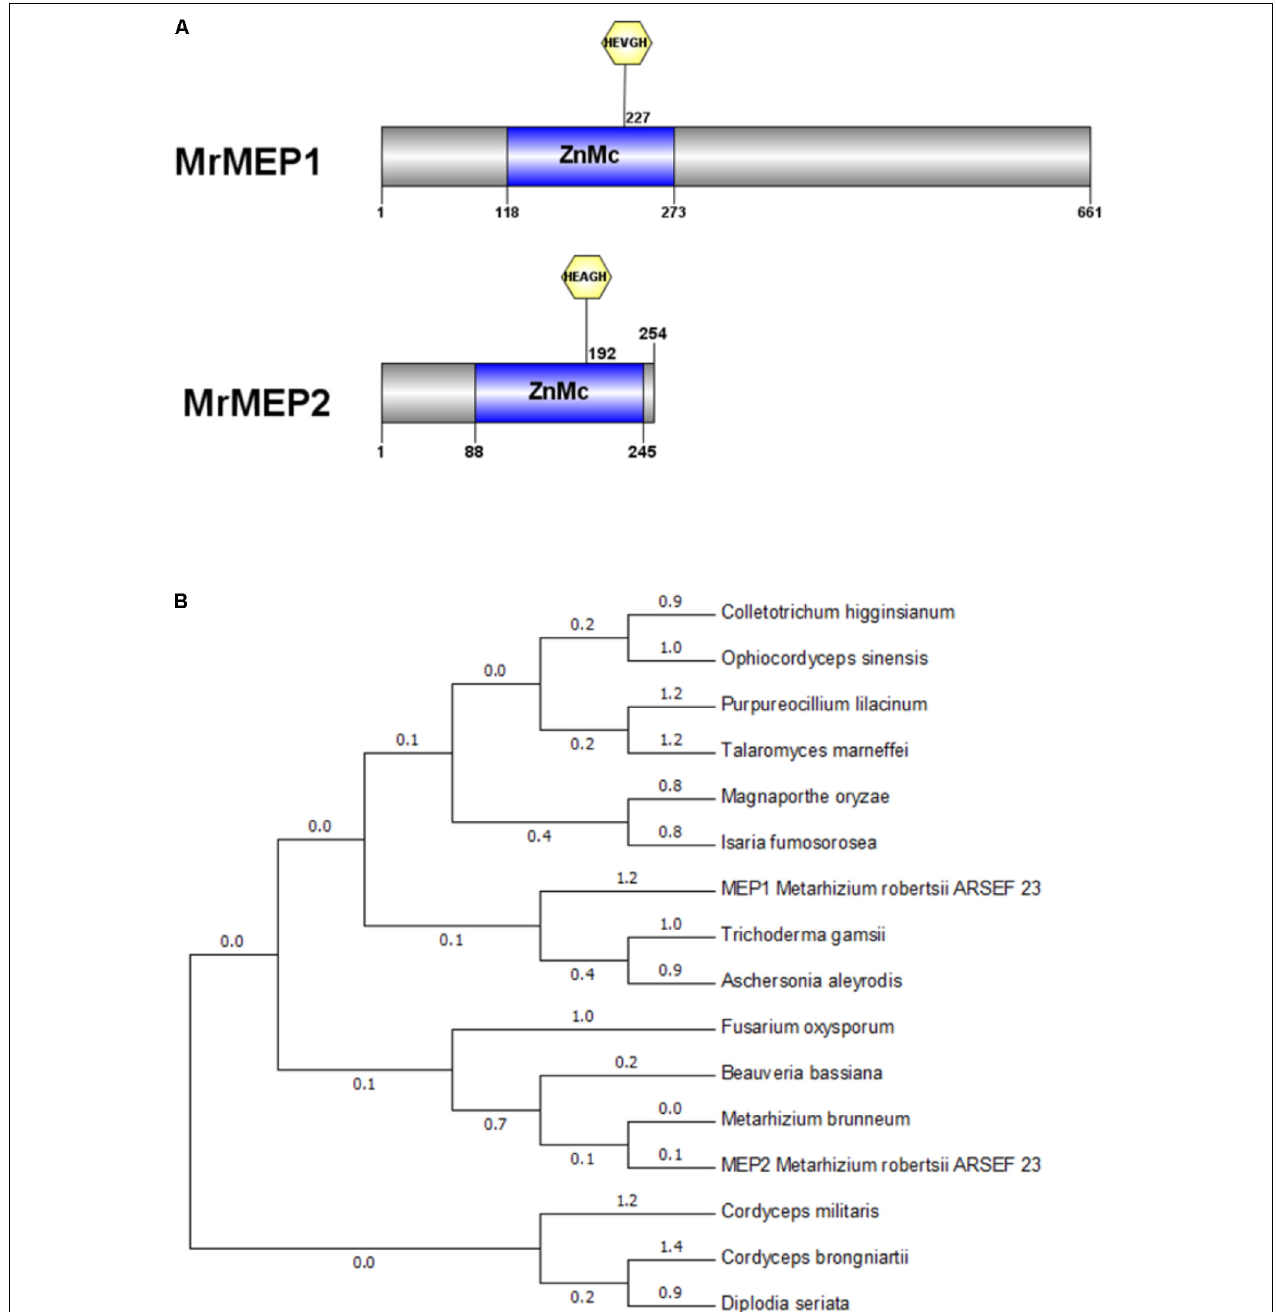
FIGURE 1 | Bioinformatic analysis of MrMEP1 and MrMEP2 proteins. (A) The structural domain sites in MrMEP1 and MrMEP2 proteins. (B) Phylogenetic analysis of the fungal MEP proteins. Phylogenetic trees constructed with fungal MEP proteins. The protein accession numbers as follows, EWZ30531.1 hypothetical protein FOZG_16010 [ Fusarium oxysporum Fo47]; PNP41669.1 hypothetical protein TGAMA5MH_06456 [ Trichoderma gamsii ]; XP_018155334.1 metalloprotease [ Colletotrichum higginsianum IMI 349063]; XP_018179452.1 metalloprotease [ Purpureocillium lilacinum ]; OAA39196.1 metalloprotease 1 [ Cordyceps brongniartii RCEF 3172]; XP_003714993.1 metalloprotease 1 [ Magnaporthe oryzae 70-15]; XP_014540809.1 metalloprotease 1, partial [ Metarhizium brunneum ARSEF 3297]; KZZ90284.1 metalloprotease MEP1 [ Aschersonia aleyrodis RCEF 2490]; XP_008593388.1 metalloprotease MEP1 [ Beauveria bassiana ARSEF 2860]; XP_002149130.1 metalloprotease MEP1 [ Talaromyces marneffei ATCC 18224]; XP_002149130.1 metalloprotease MEP1 [ Talaromyces marneffei ATCC 18224]; XP_018708221.1 peptidase M43, pregnancy-associated plasma-A [ Isaria fumosorosea ARSEF 2679]; XP_006674200.1 peptidase M43B, pregnancy-associated plasma-A [ Cordyceps militaris CM01]; EQL01370.1 protein related to metalloprotease MEP1 [ Ophiocordyceps sinensis CO18]; KKY13372.1 putative metalloprotease 1 [ Diplodia seriata ]; EFY97549.1 metalloprotease MEP1-like protein [ Metarhizium robertsii ARSEF 23]; EFY97706.1 metalloprotease 1 [ Metarhizium robertsii ARSEF